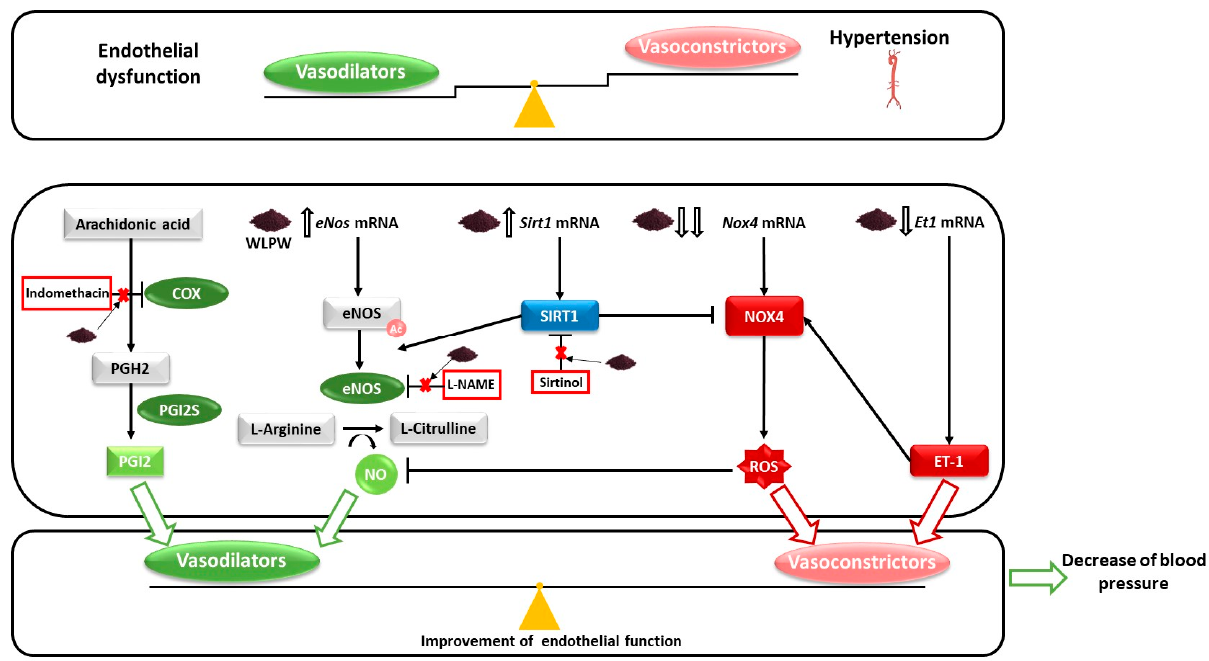
Figure 6. Schematic representation of the molecular mechanisms involved in the blood pressure (BP)-lowering effect of wine lees powder (WLPW) in endothelium. WLPW upregulates endothelial nitric oxide ( eNos ) mRNA levels, which would lead to higher production of nitric oxide (NO). WLPW increases plasma NO levels [15]. Sirtuin-1 ( Sirt1 ) mRNA levels are